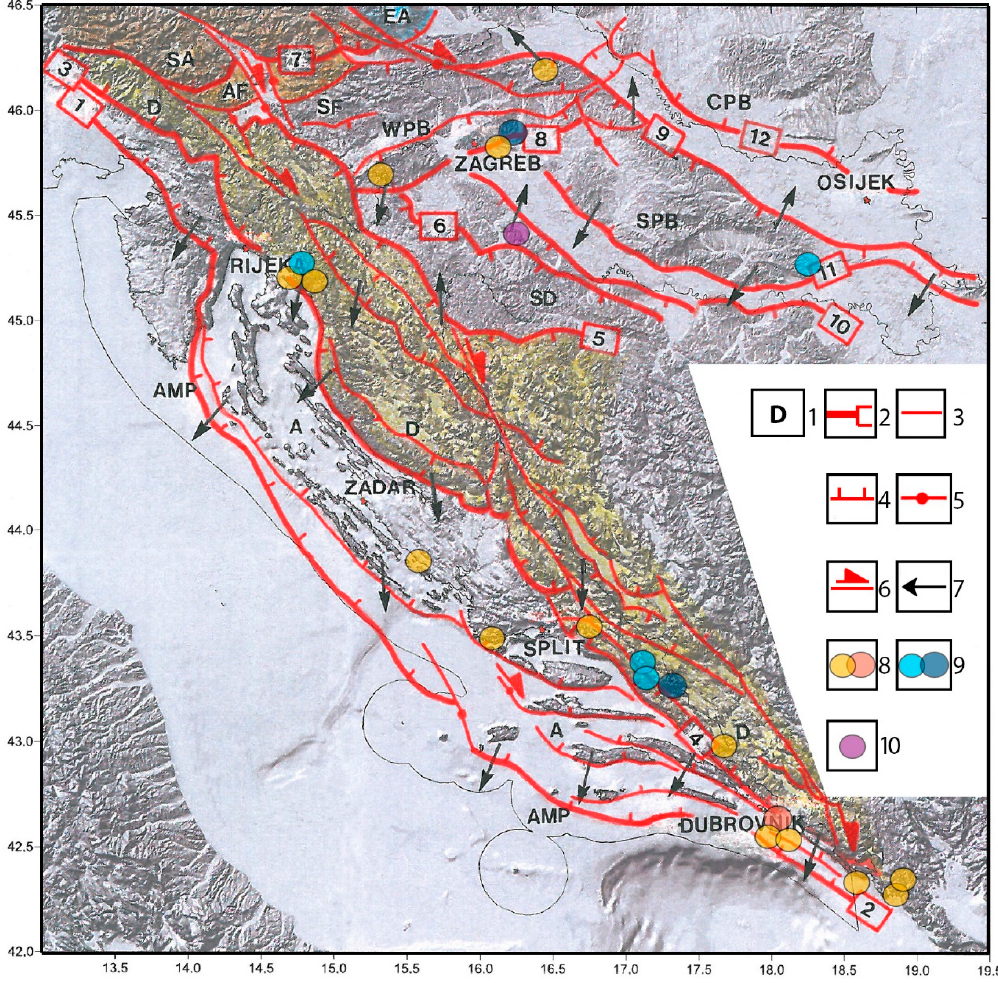
Figure 3. Recent geological structure setting and basic directions of movement of structural parts along the surface according to geological data. Legend: 1—Regional geological structural units: a—Adriatic microplate (AMP) and Adriatic unit (A); b—Southern Alps (SA), Prealps (AF), and Sava faults (SF); c—Dinarides: Dinaric and Supradinaric (SD); d—Pannonian Basin: Western (WPB), Southern (SPB), and Central part (CPB); 2—The most important faults bordering regional structural units: Trieste–Uˇcka–Vis fault (1), Vis–South Adriatic fault (2), Postojna–Rijeka–Vinodol fault and extension, Velebit– Sinj fault (3), Mosor–Biokovo–Dubrovnik fault (4), Fela–Sava fault and continuation, Ljubljana–Karlovac–Slunj fault (5), southern boundary fault of the Pannonian Basin (6), fault of the Southern Alps (7), Zagreb fault (8), Periadriatic fault and continuation and Drava fault (9), Sava fault (10), Zagreb–Vinkovci fault (11), and Barcs–Baranja fault (12); 3—other important faults; 4—reverse faults; 5—faults of indeterminate character; 6—direction of horizontal movement along the fault; and 7—direction of movement of structure parts along the surface according to geological data; 8—earthquake epicentres, intensity IX and X, yr. 361–1900; 9—earthquake epicentres yr. 1901–1970, M 5.7-6.1 and M 6.2-6.6; 10—earthquake epicenter M 6.2, south of Zagreb in